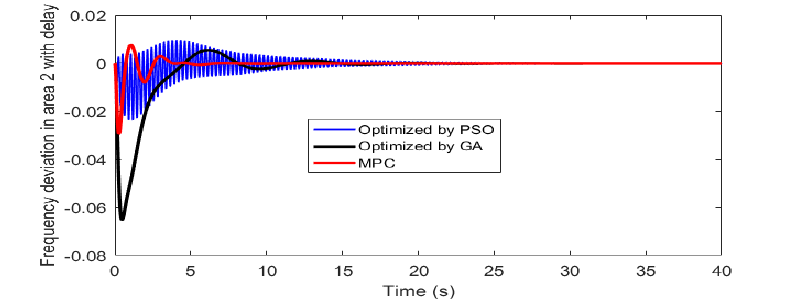
Figure 17. Frequency deviation in Area 2 for the fourth case.